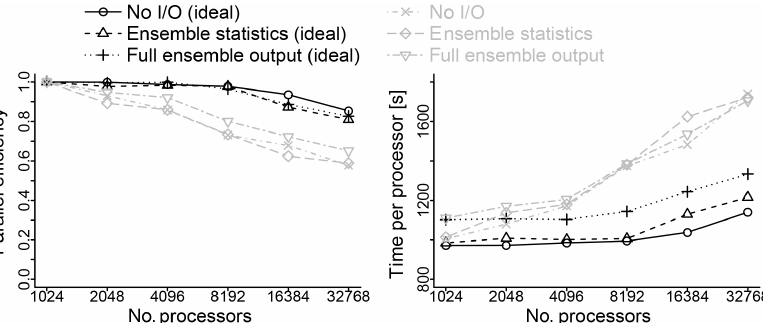
Figure 7. Scaling behaviour (left) and timing information (right) for TerrSysMP–PDAF for a weak scaling test on JUQUEEN. Black lines show results for an idealised test case (identical ensemble members) and grey lines show results for a heterogeneous ensemble. The number of ensemble members is increased from 8 to 256. Each ensemble member used 32 processors for CLM and 96 processors for